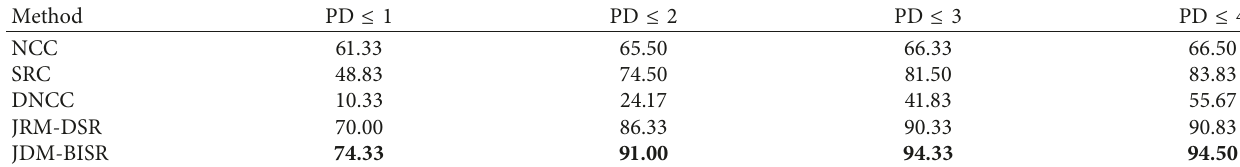
Table 3: The matching accuracy of different methods, where the standard deviation of Gaussian blur kernel is 3.